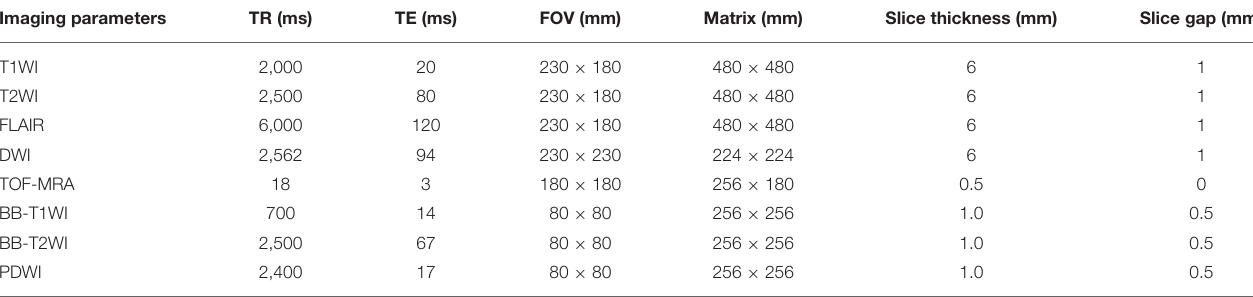
TABLE 1 | Imaging parameters for each sequence. Imaging parameters